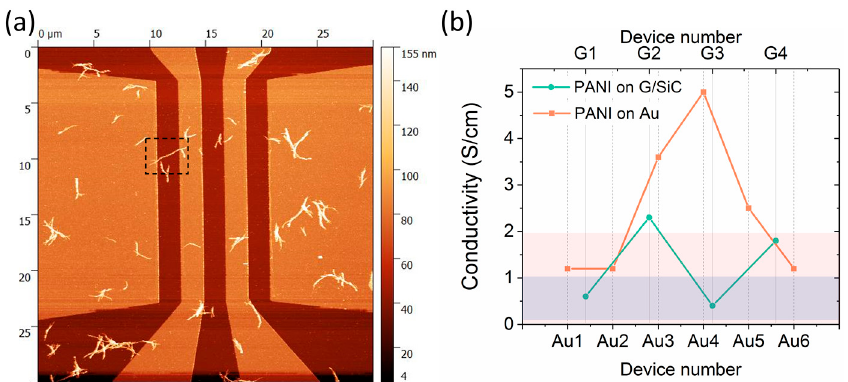
Figure 5. Comparison of graphene and gold as contact for PANI nanofibers. ( a ) AFM topography of PANI nanofibers contacted on Au electrodes (Au4, Figure S2). The contact of a PANI nanofiber contacted by Au electrodes is indicated by a dotted box. ( b ) Conductivity of PANI nanofibers measured on both Au (Au1–Au6, Figures S1–S4) and graphene electrodes (G1–G4, Figures S5–S7). The blue (red) shaded region is the conductivity of PANI nanofibers (annealed PANI nanofibers at 800 ° C) measured on Au electrodes in Ref [64] (Ti/Au bottom contact electrode in Ref. [59]).